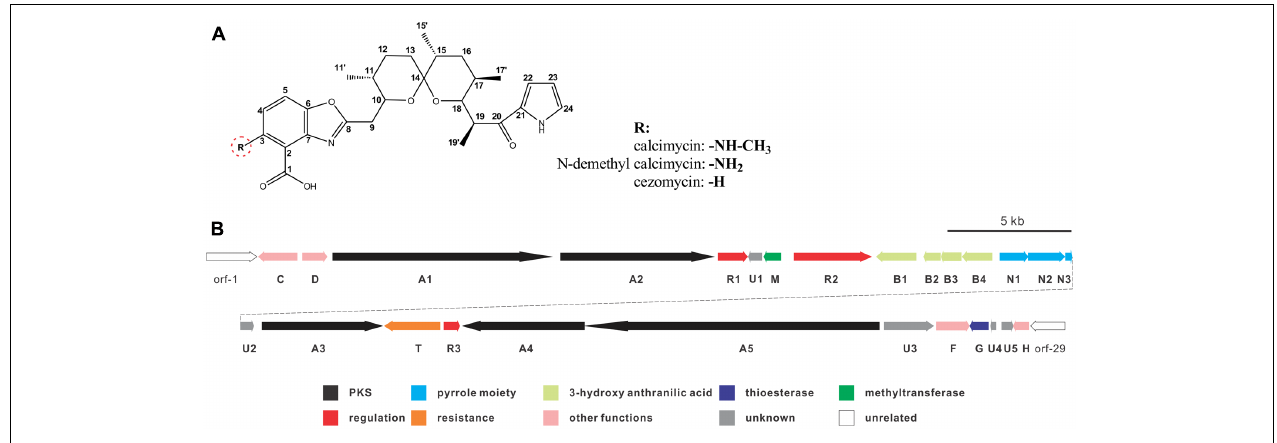
FIGURE 1 | Chemical structure of calcimycin and its precursors (A) and genetic organization of the calcimycin gene cluster (B) .